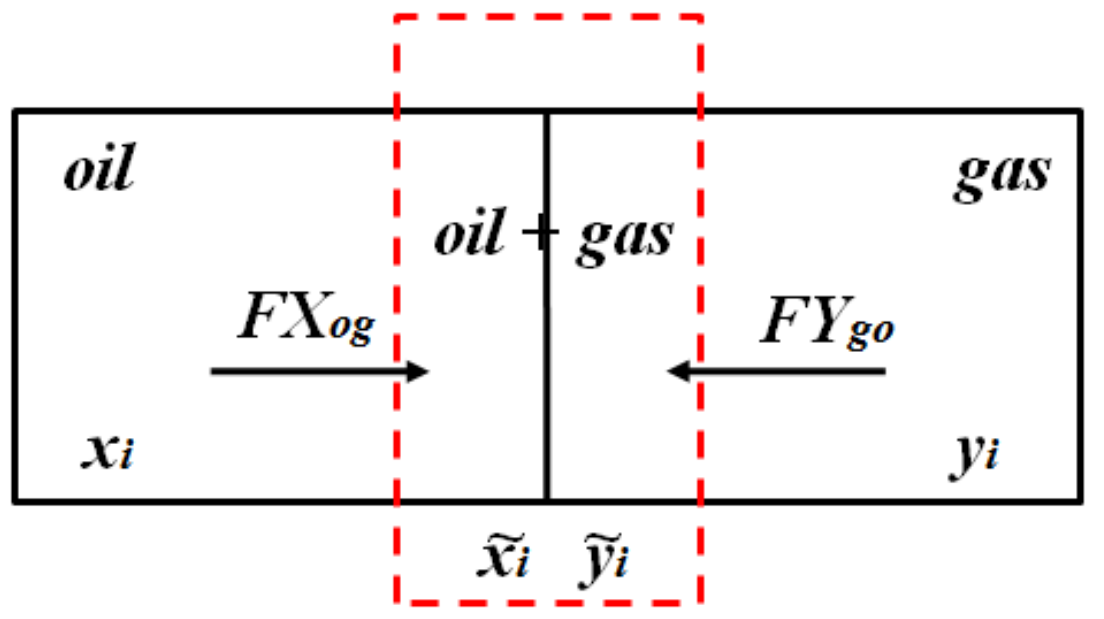
Figure 3. Scheme of diffusion between phases.